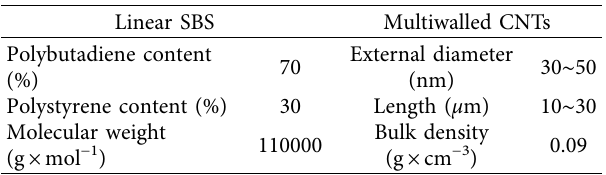
Figure 1: CNTs used in the test. (a) CNTs-I. (b) CNTs-II. Table 2: Key technical characteristic parameters of SBS polymer and CNTs.